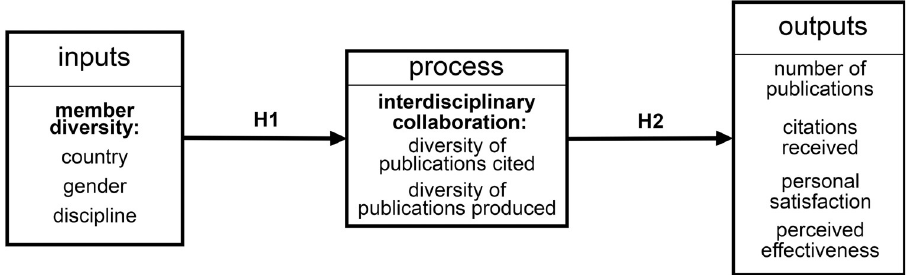
Fig 1. Research model. Inputs, mediators (process and emergent states) and outputs. Hypothesis numbers are